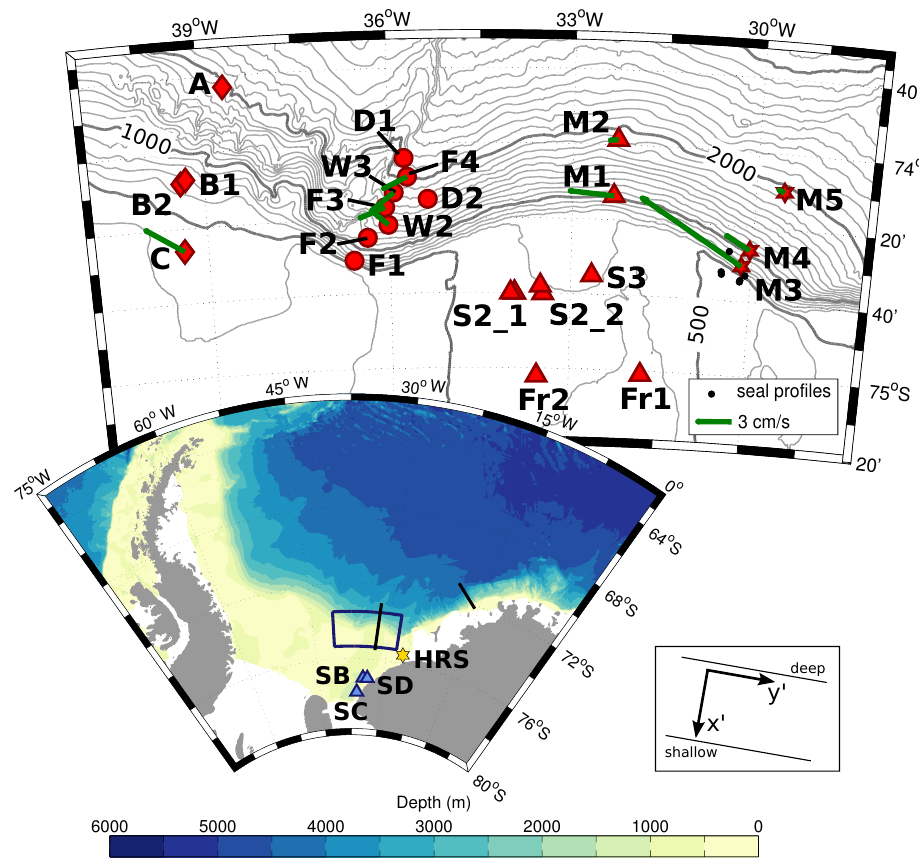
Figure 1. Map of the Weddell Sea (bathymetry from the GEBCO_2014 grid, version 20150318, http://www.gebco.net) and locations of moorings in the study area (shapes according to their location west, along the ridge, at and in the Filchner Depression, or east on the continental slope). S2_1 and S2_2 show the location of mooring S2 prior to and after 2000. Annual mean currents (see Sect. 2) are indicated by green arrows. The study area is also the area the sea ice concentration has been averaged over. The yellow star marks Halley Research Station (HRS), while the two black lines indicate cross-slope sections used for the bathymetry test in the numerical code and to derive diurnal tidal KE from the tidal model CATS. The inset in the lower right corner illustrates the orientation of the coordinate